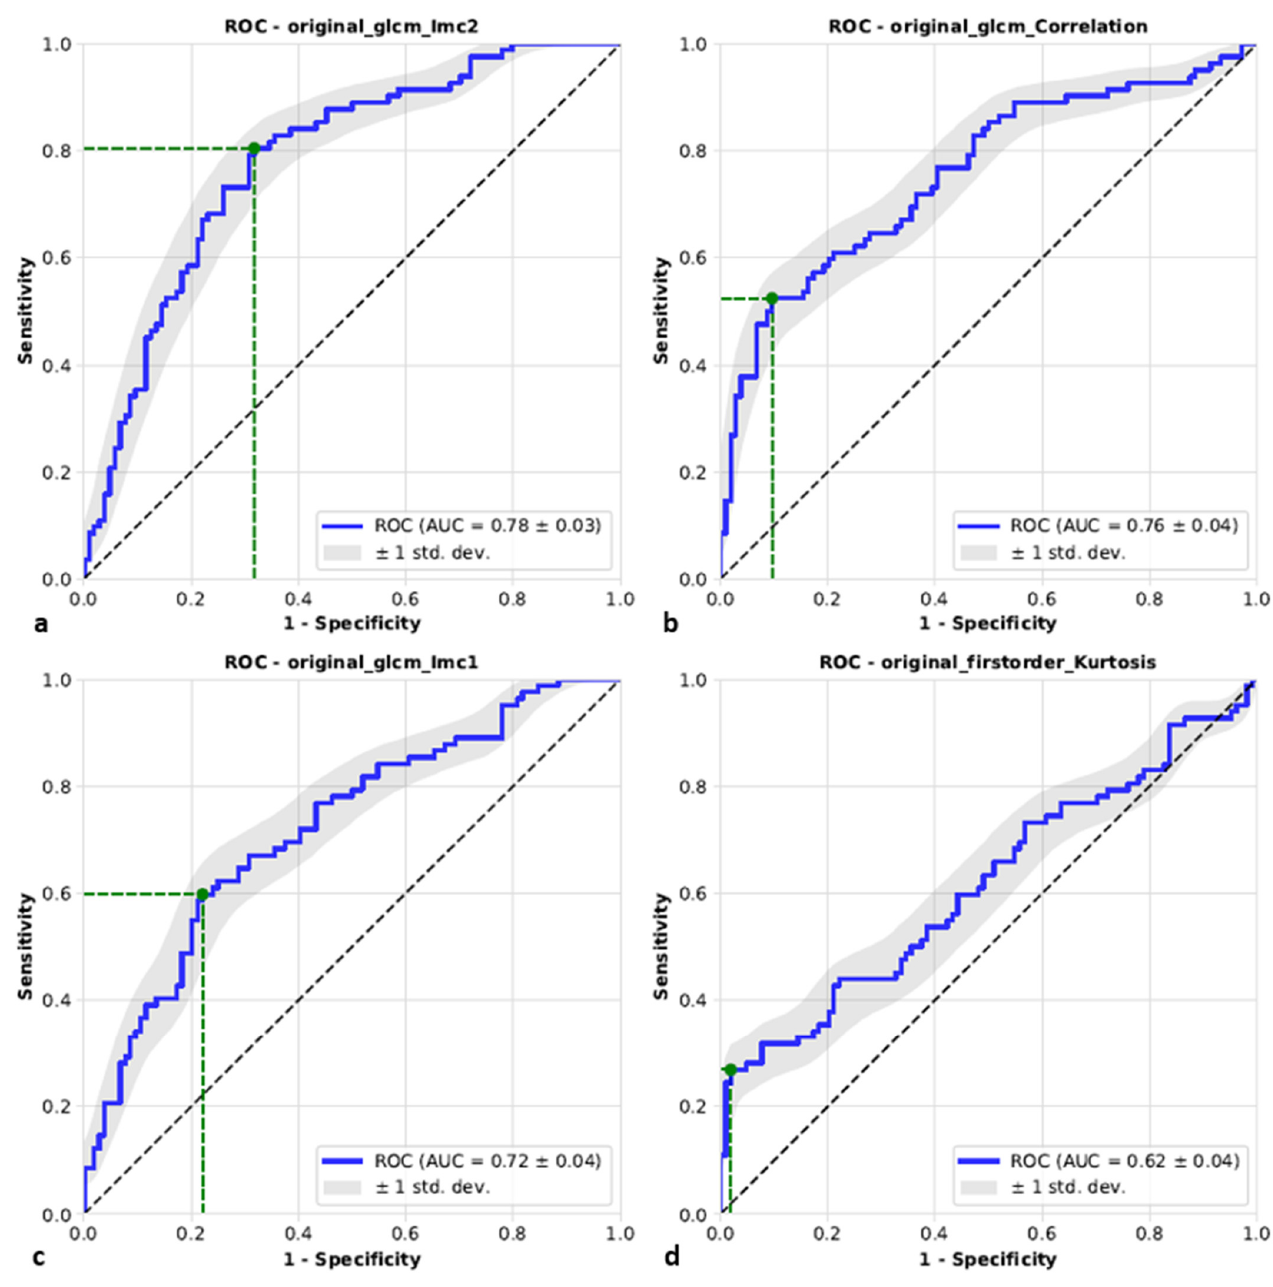
Figure 3. Receiver operating characteristics curves (ROCs) demonstrating the accuracy of each of the four univariate predictive models in the binary prediction for informational measure of correlation 2 (IMC2) ( a ), correlation ( b ), informational measure of correlation 1 (IMC1) ( c ) and kurtosis ( d ). The ROCs are based on 186 segmentations in PRE-CT, thereof 82 segmentations with HCC later confirmed in the FU-CT and 104 segmentations without HCC in the FU-CT. The working point was determined by maximizing sensitivity + specificity. IMC1 and IMC2 and correlation represent texture features, whereas kurtosis is a representative of the first-order features and specifies the peaked-ness of the distribution of values in the segmentation. GLCM—gray level co-occurrence matrix features, HCC—hepatocellular carcinoma, PRE-CT—computed tomography prior to detection of a newly emerged HCC, FU-CT—follow-up computed tomography at the time of detection of a newly emerged